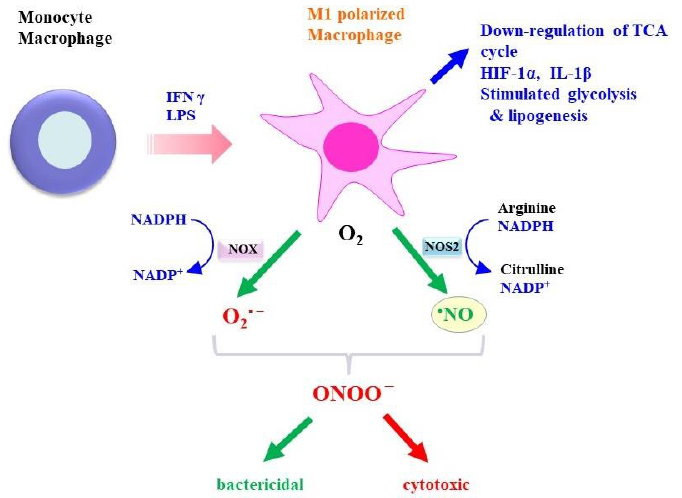
Figure 1. Properties of M1 macrophages: Upon stimulation by IFN γ and LPS, macrophages are